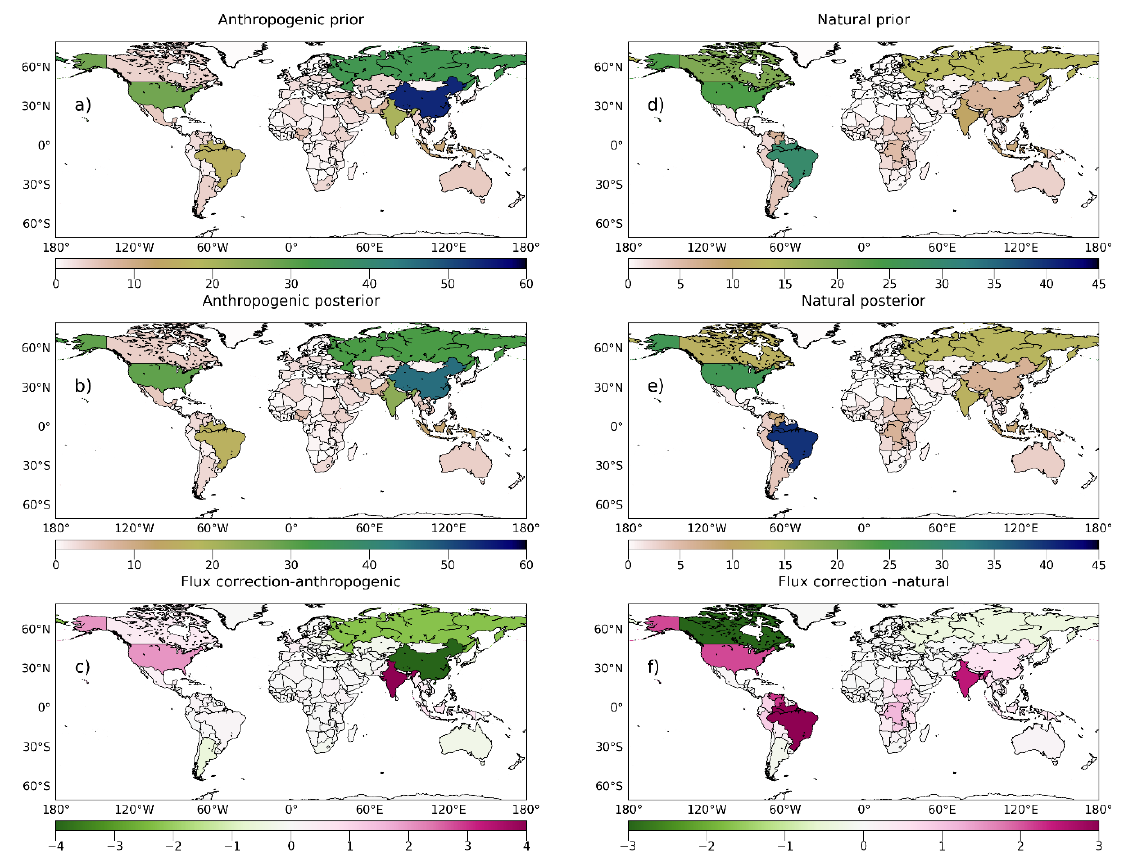
Figure 4. The mean annual total emissions aggregated (2011–2017) for each country for anthropogenic (left panels) and natural (right panels) categories. ( a ) and ( d ) (upper panel) Prior, ( b ) and ( e ) (middle panel) posterior, and ( c ) and ( f ) (bottom panel) correction fluxes in Tg CH 4 yr − 1 units are given.